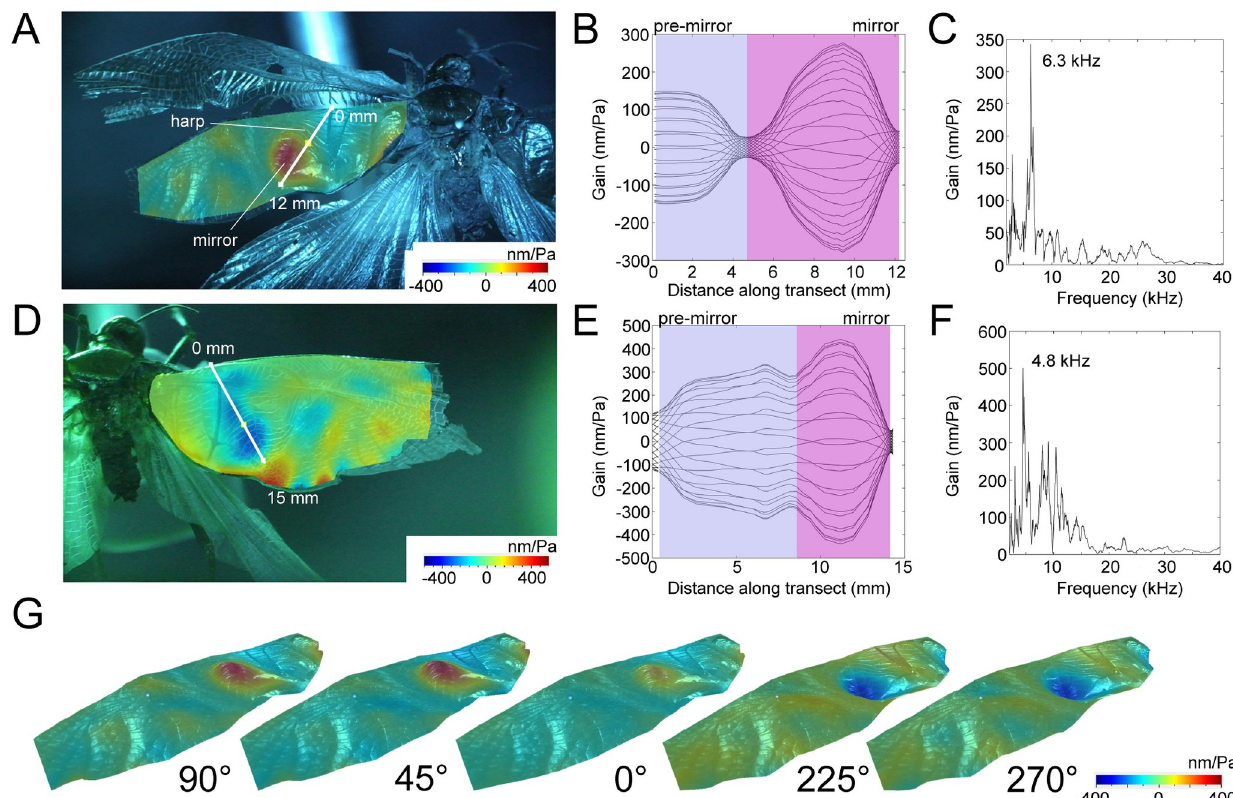
Fig 3. Forewing resonance in Prophalangopsis obscura . (A) Displacement map of the LW; (B) Deflection pattern of the white profile line in A; (C) Frequency spectrum of the left mirror; (D) Displacement map of the RW; (E) Deflection pattern of the profile line in D; (F) Frequency spectrum of the right mirror; (G) Angled view of the left forewing displacement pattern at 4.8 kHz.